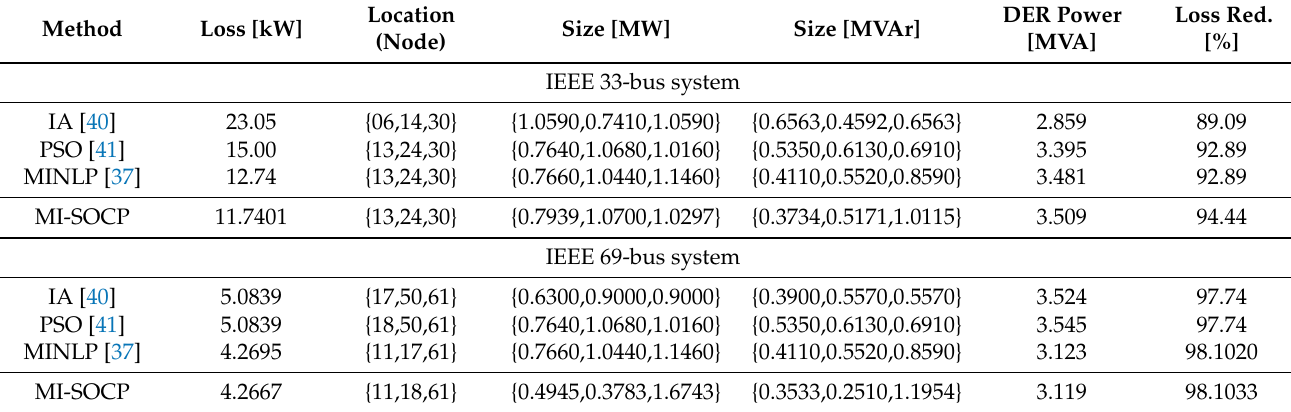
Table 3. Comparative results for the optimal placement and sizing of DERs for the IEEE 33-bus and IEEE 69-bus systems for Case-2.